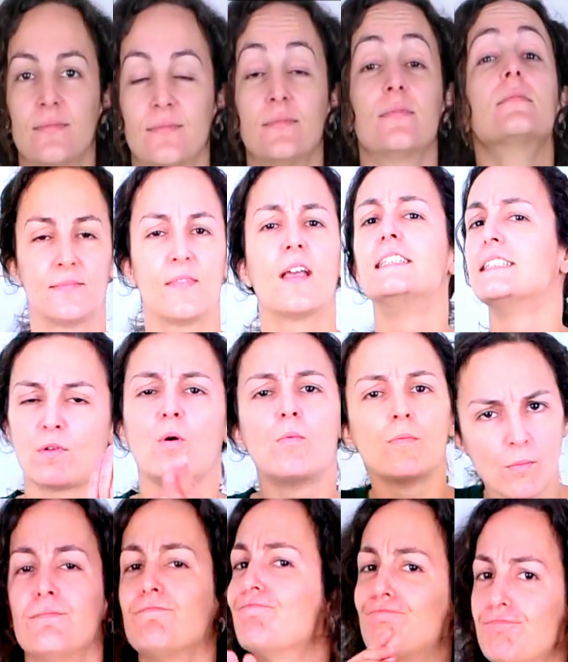
Figure 2. Example of FE classes in LSE_GFE dataset. Rows from top to bottom: None, q.polar, q.partial,